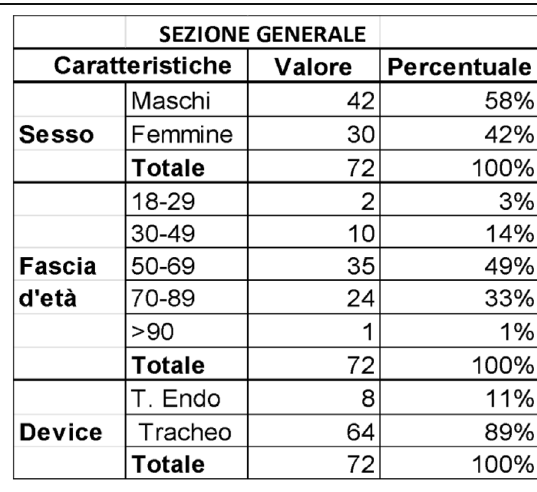
Table 1 (abstract A34). Patients characteristics and